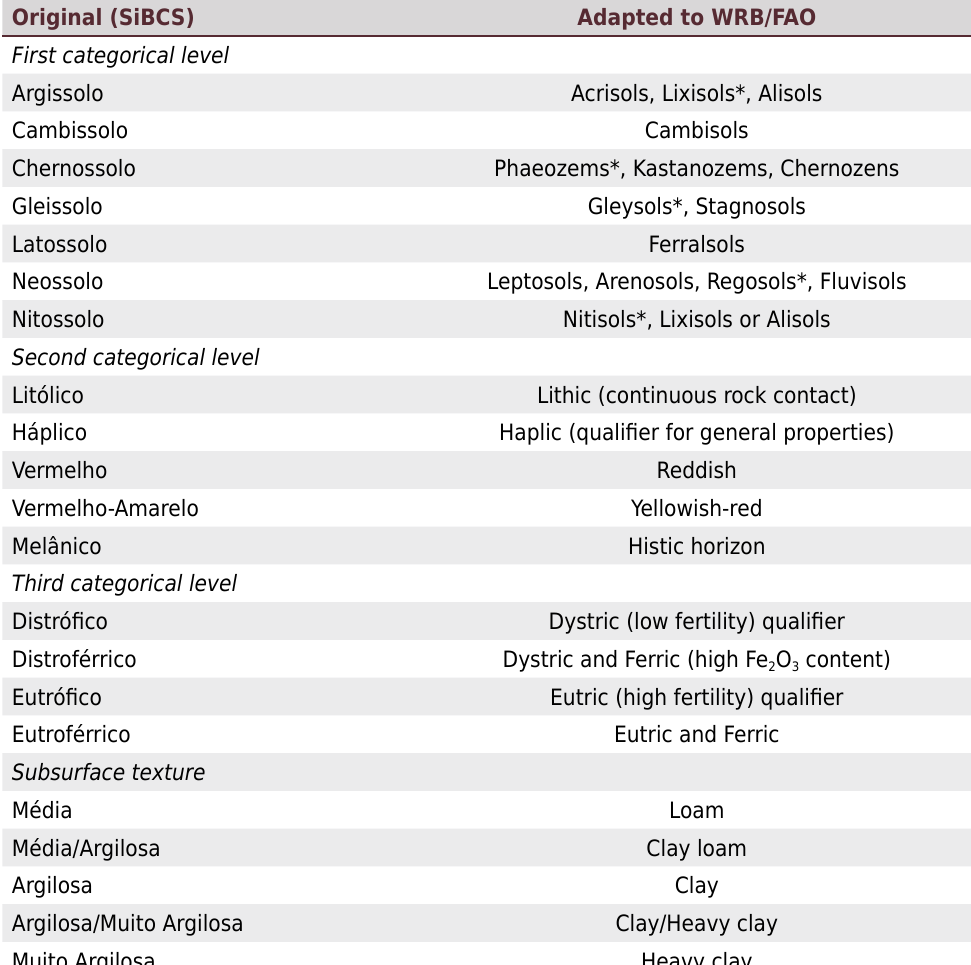
Table 2. Conversion of classification terms from the Brazilian Soil Classification System - SiBCS (Santos et al., 2018) to World Reference Base – WRB/FAO (IUSS Working Group WRB, 2015) Original (SiBCS) Adapted to